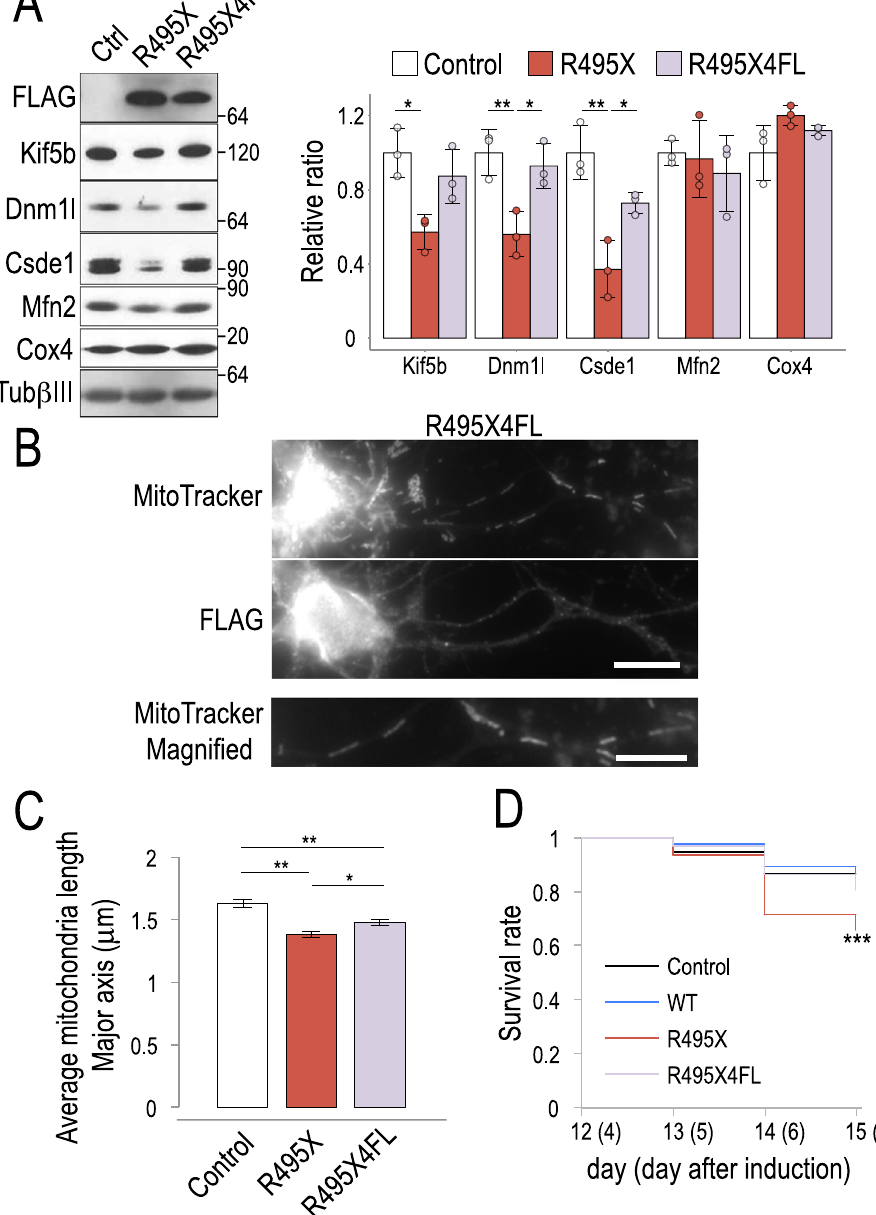
Figure 7. R495X4FL partially rescues R495X induced mitochondria shortening and neurotoxicity. ( A ) Immunoblots for control, R495X- and R495X4FL-expressing neurons (left) and bar plot for normalized protein band intensities (right). Average band intensity for control was set to 1. Protein standard is shown on the right. Error bars indicate standard deviation (N = 3). P-values in one-way ANOVA are, 0.015, 0.009, 0.003, 0.731 and 0.093 for Kif5b, Dnm1l, Csde1, Mfn2 and Cox4, respectively and * p < 0.05 and ** p < 0.01 in post Tukey’s HSD test. ( B ) Staining images using MitoTracker (top) and anti-FLAG antibody (middle) with magnified images of MitoTracker stained neuronal processes (bottom) of an R495X4FL-expressing neuron. Scale bar, 10 μ m (middle) and 5 μ m (bottom). ( C ) Average mitochondria major-axis length for control, R495X- and R495X4FL-expressing neurons. 880 mitochondria from 10 cells expressing R495X4FL were analyzed. Data for control and R495X are copied from Fig. 5C. Error bars indicate standard error. P-value in one-way ANOVA is < 0.0001 and * p < 0.05 and ** p < 0.01 in post Tukey’s HSD test. ( D ) Cell survival curve for control, WT-, R495X- and R495X4FL- expressing neurons. The number of surviving cells at days 13–15 are expressed as the ratio over those surviving at day 12 (y-axis). The numbers in parenthesis indicate the day after induction. *** p < 0.003, log-rank